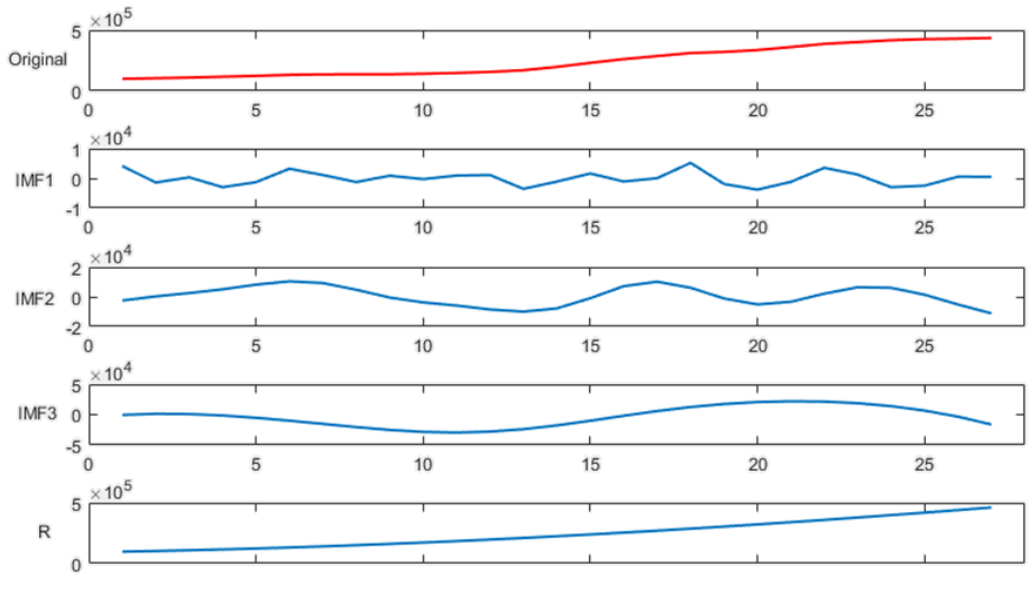
Figure 5. The IMFs of EEMD.